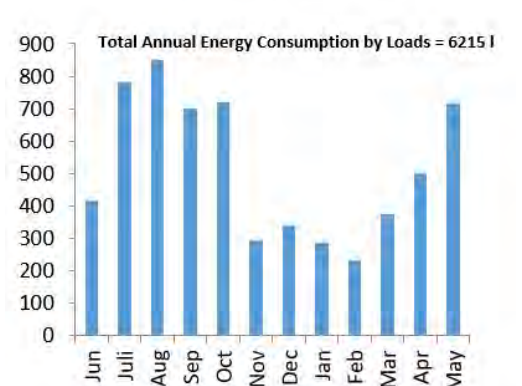
Figure 6. MonthlyLoads Energy Consumptions in kWh